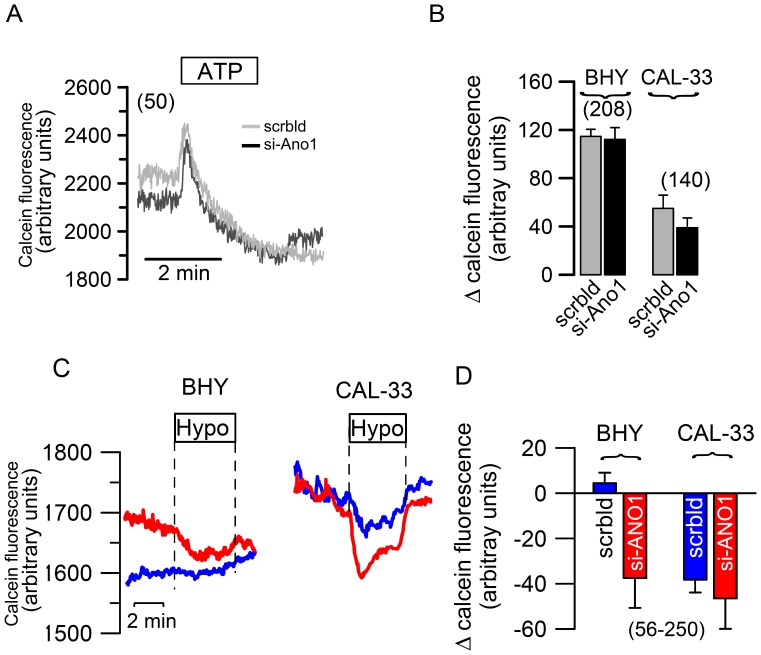
Ano1 supports regulatory volume decrease.A) Original recordings of the calcein fluorescence in BHY cells, treated with scrambled RNA or siRNA-Ano1, before and after stimulation with 100 µM ATP. ATP induces transient cell shrinkage that was not affected by siRNA-knockdown of Ano1. B) Summary of the ATP-induced changes in calcein fluorescence in BHY and CAL-33 cells treated with scrambled RNA or siRNA-Ano1. C) Original recordings of calcein fluorescence in BHY and CAL-33 cells treated with scrambled RNA (blue) or siRNA-Ano1 (red) and effect of a hypotonic (Hypo; 200 mosmol/l) bath solution. D) Summary of the hypotonicity-induced changes in calcein fluorescence in BHY and CAL-33 cells treated with scrambled RNA or siRNA-Ano1. Mean ± SEM, (number of experiments). *indicates significant difference (p<0.05, paired t-test). #indicates significant difference (p<0.05, paired t-test).